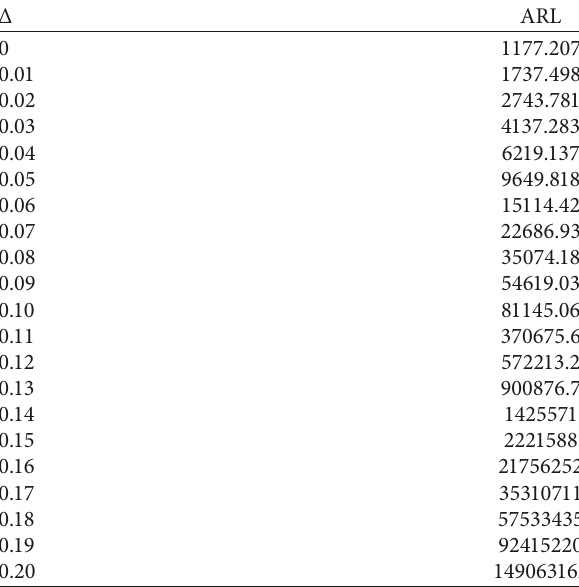
Table 4: Impact of estimation error for R